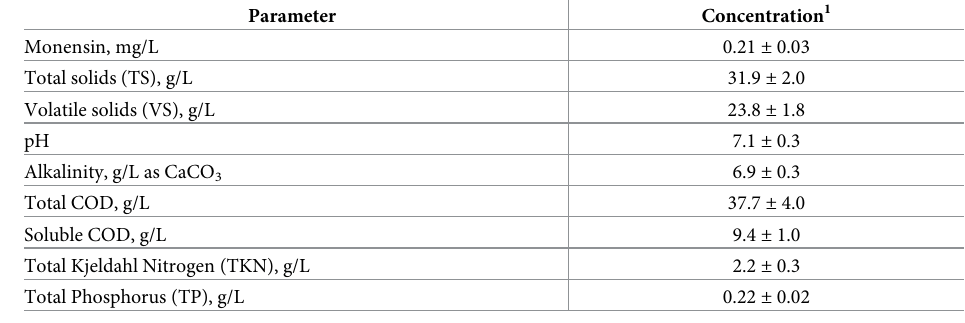
Table 1. Characteristics of dairy manure used as feedstock in the